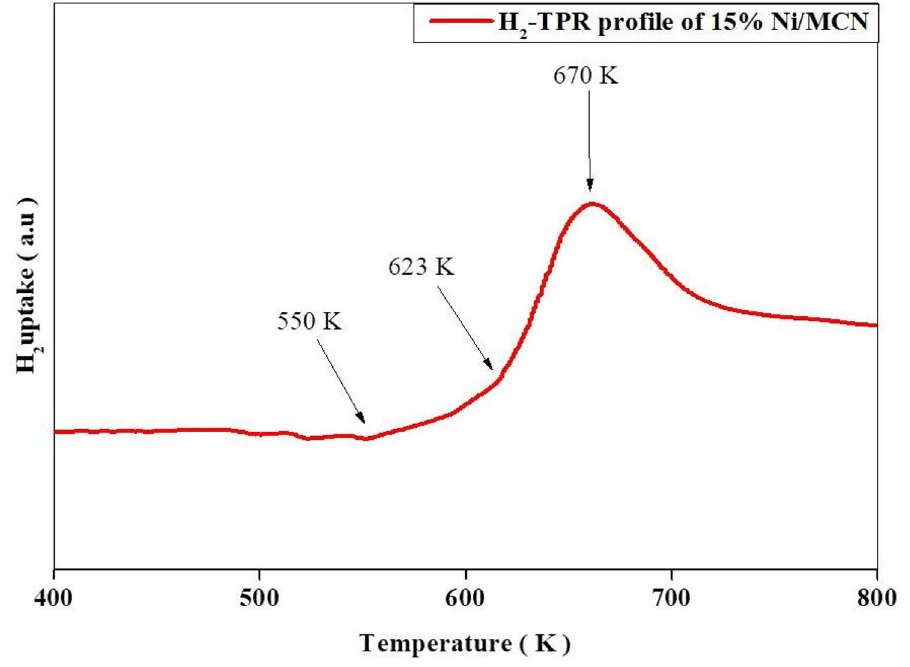
Figure 7. H 2 -TPR profile of 15% Ni/MCN.